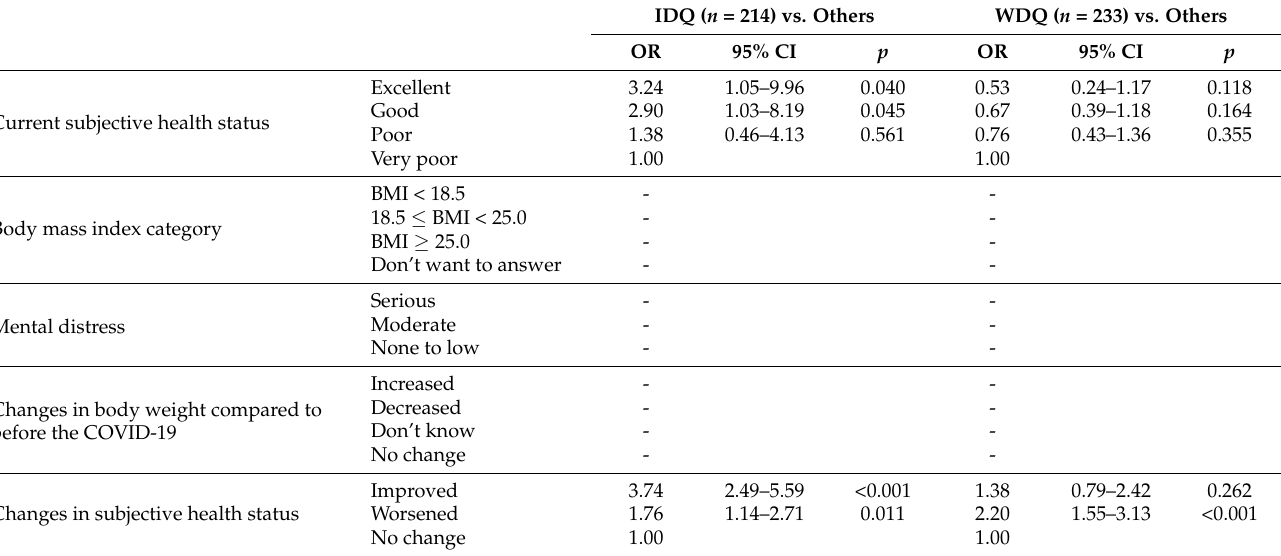
Table 5. Multinomial logistic regression analyses of participants’ health status associated with changes in diet